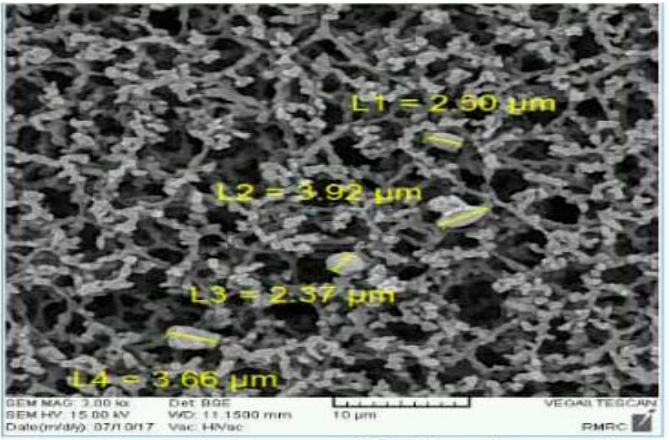
Figure 20. Results of SEM analysis.